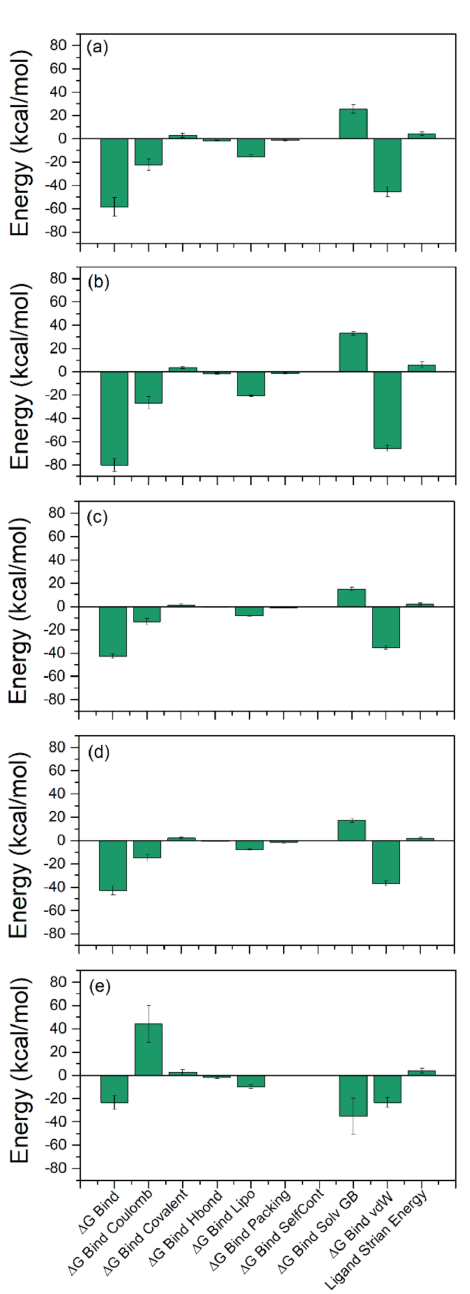
Figure 7. Binding free energy calculated for the snap shots for SARS-CoV-2 M pro complexes with potential bioactive compounds, i.e., ( a ) licuraside, ( b ) glucoliquiritin apioside, ( c ) 7,3 (cid:48) -Dihydroxy-5 (cid:48) - methoxyisoflavone, ( d ) licuroside, and ( e ) glycyrrhizin, from